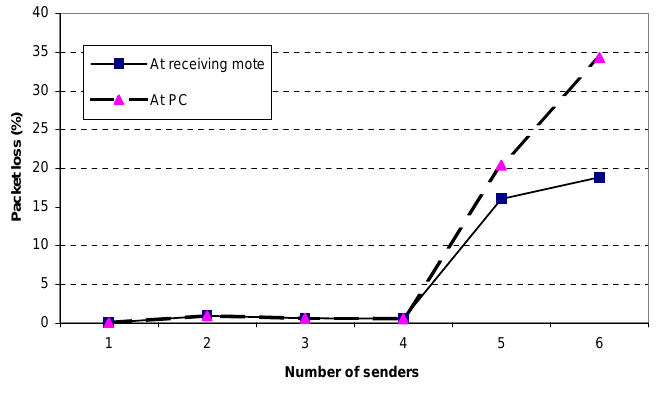
Figure 12. Packet loss at receiving mote and PC as a function of the number of senders (maximum possible sending rate).